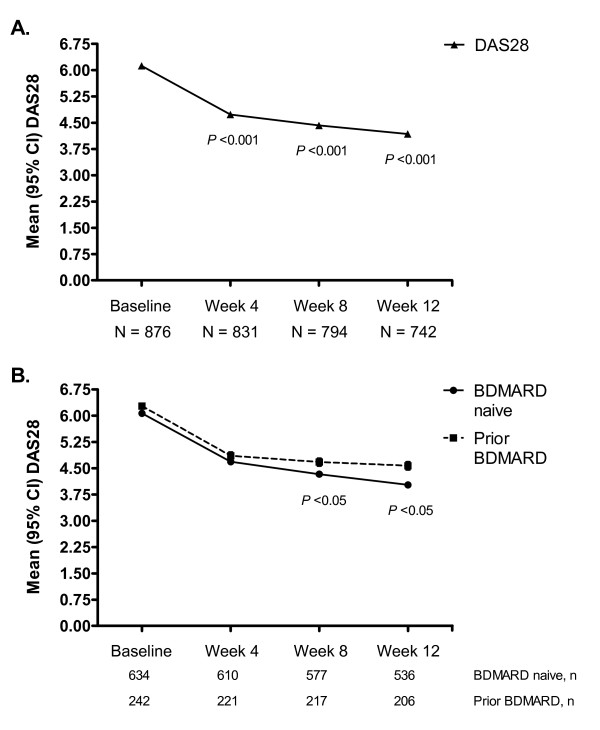
Changes Over Time in the Mean 28-joint Disease Activity Score (DAS28). Mean change (95% confidence intervals [CI]) in DAS28 in patients receiving adalimumab 40 mg administered subcutaneously every other week with concomitant standard antirheumatic therapy. A.) All randomized patients. The mean DAS28 at Weeks 4, 8, and 12 were significantly lower than the mean DAS28 at baseline (P < 0.001). B.) Subgroup analysis of randomized patients on the basis of experience with biological DMARD (BDMARD) therapy. The mean DAS28 at Weeks 8 and 12 was significantly lower in BDMARD-naïve patients than in patients who experienced prior BDMARD therapy (P < 0.05).